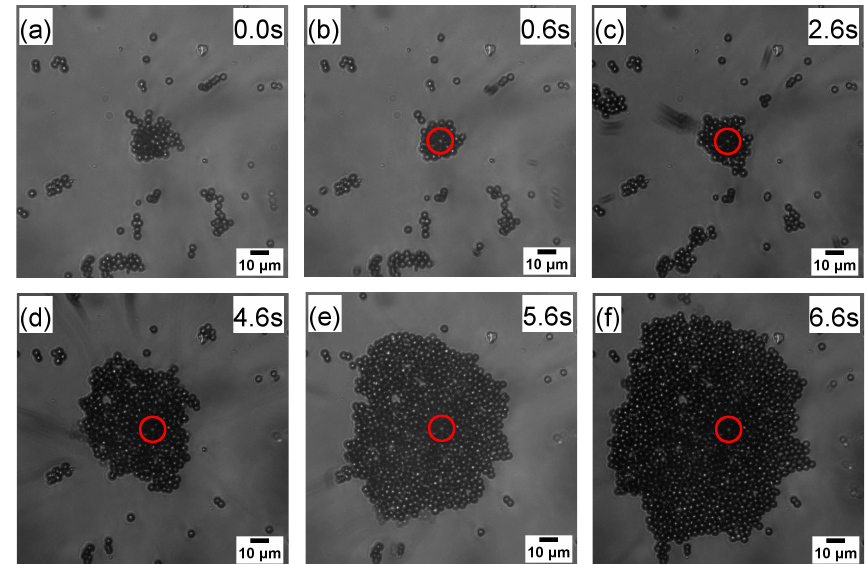
Figure 2. Images of forming absorbing particle (AP) aggregates. ( a ) No laser illuminating, the APs do not move. ( b – f ) The process of laser induced particles aggregation. The APs begin to accumulate when the laser begins to illuminate on a small aggregate at time = 0.6 s. The APs move to the heat center, and form a large AP aggregate. P = 18 mW at the pupil of the objective. The circle indicates the focal center of the laser beam. The thickness of the suspension layer was 70 µ m. Scale bar, 10 µ